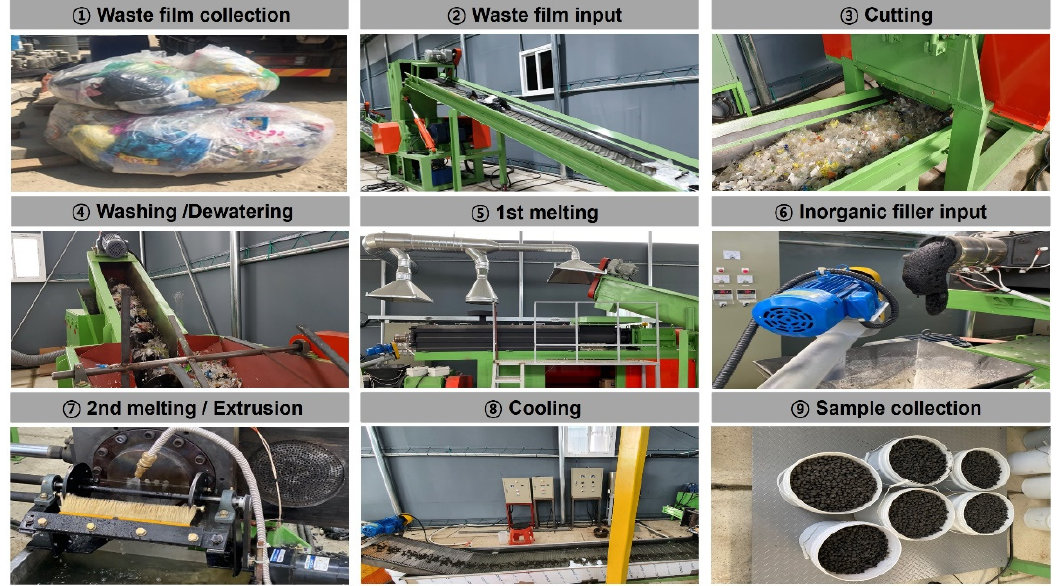
Figure 1. Production processes of recycled plastic film-based aggregates.